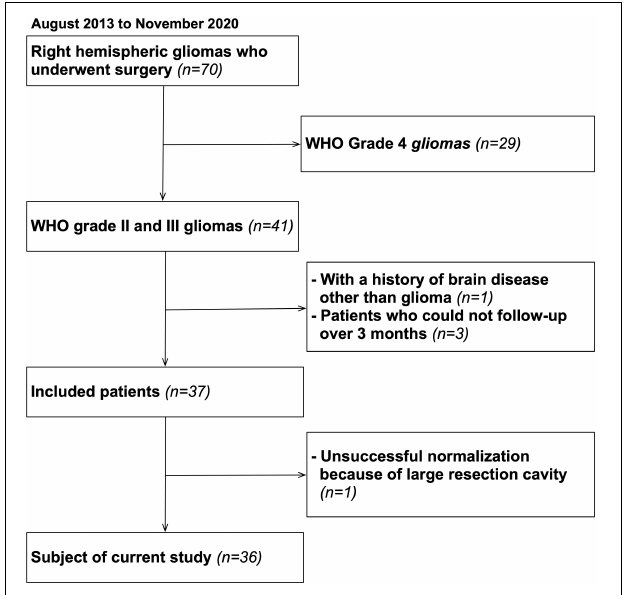
FIGURE 1 | Flow chart of the inclusion